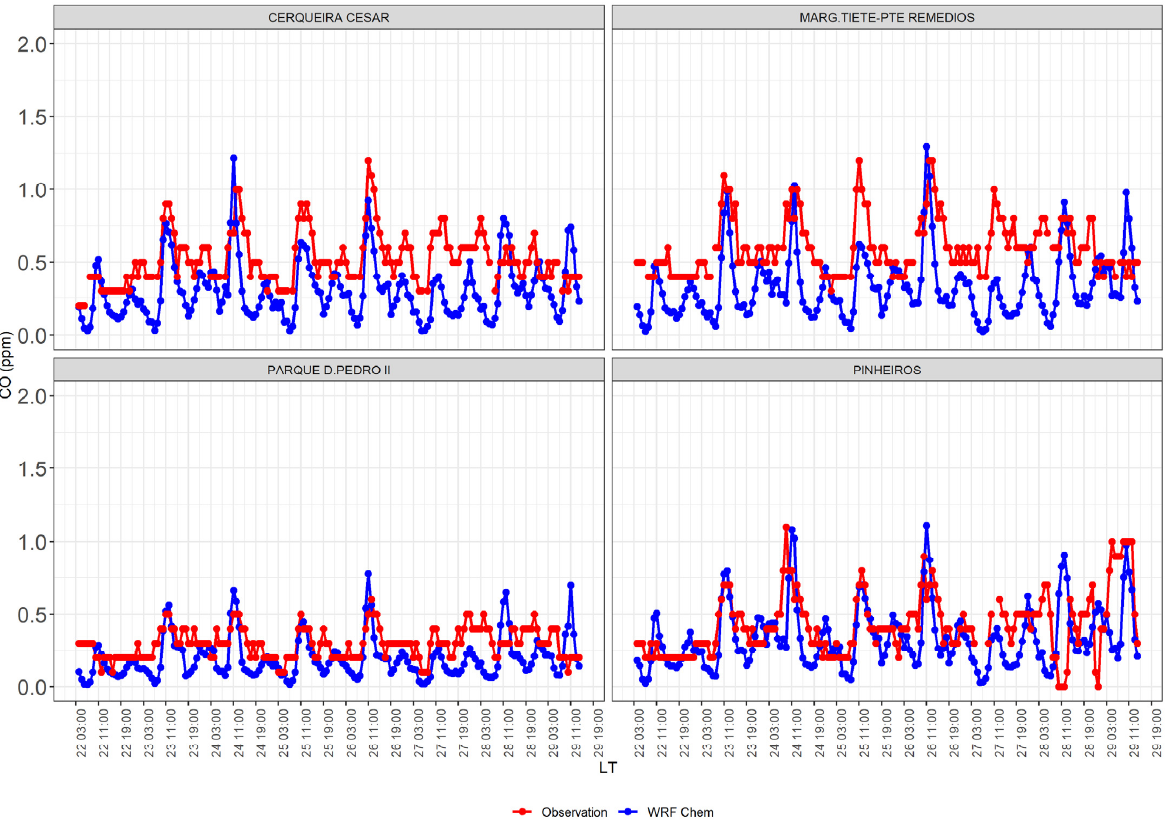
Figure 3. Concentrations of CO (ppm) for the stations Cerqueira Cesar, Marg. Tietê-Pte Remedios, Parque D. Pedro II and Pinheiros during April 2018.